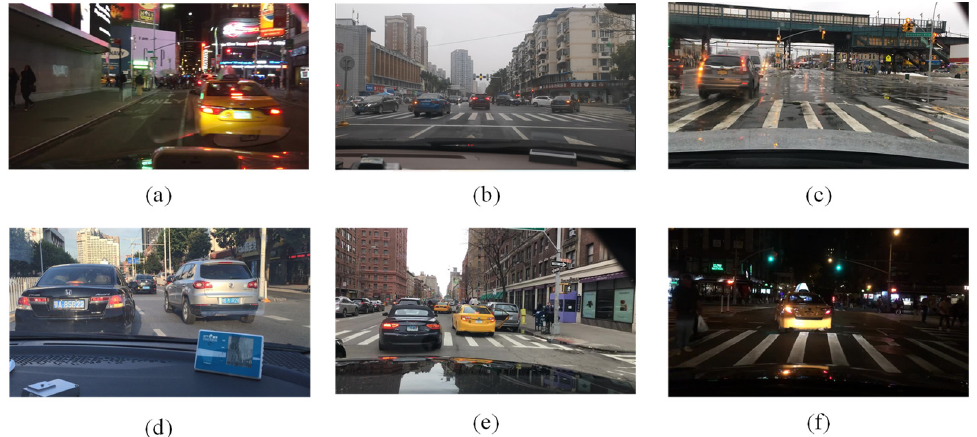
Figure 1. Samples of the vehicle taillight detection dataset. ( a ) Multi-light source scenario. ( b ) Crossroad scenario. ( c ) Rain scenario. ( d ) Lane change scenario. ( e ) Simple scenario. ( f ) Night scenario.